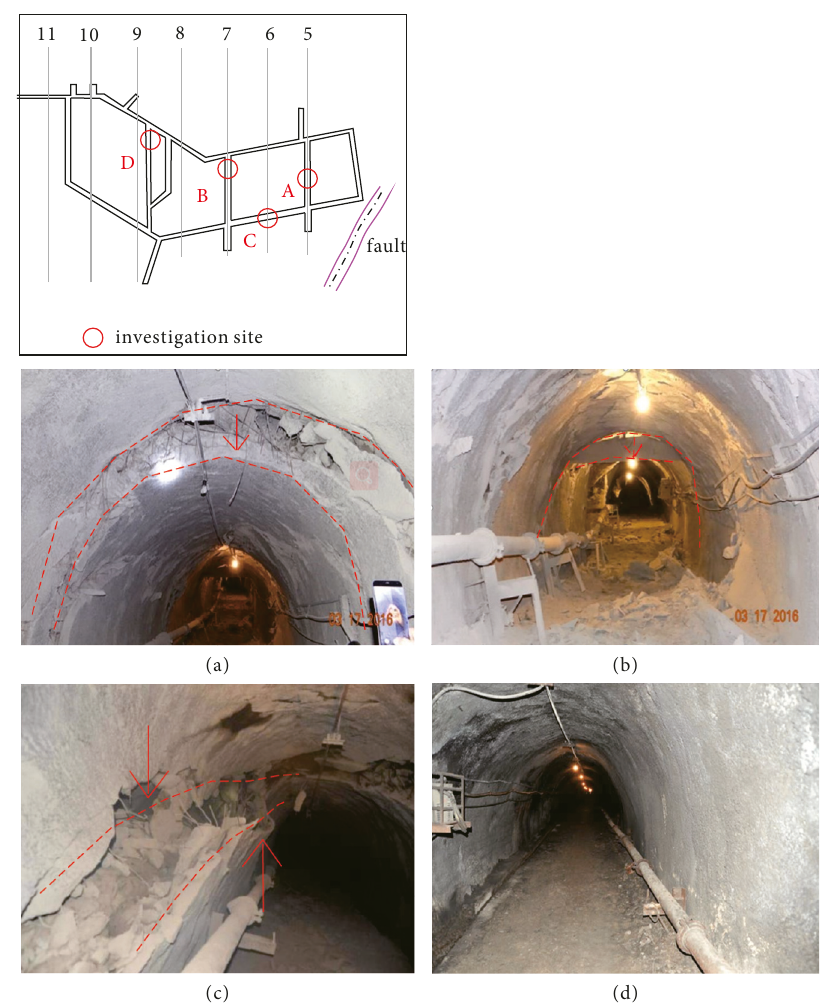
Figure 7: The location of the investigation and the filed destructions at the 1650m